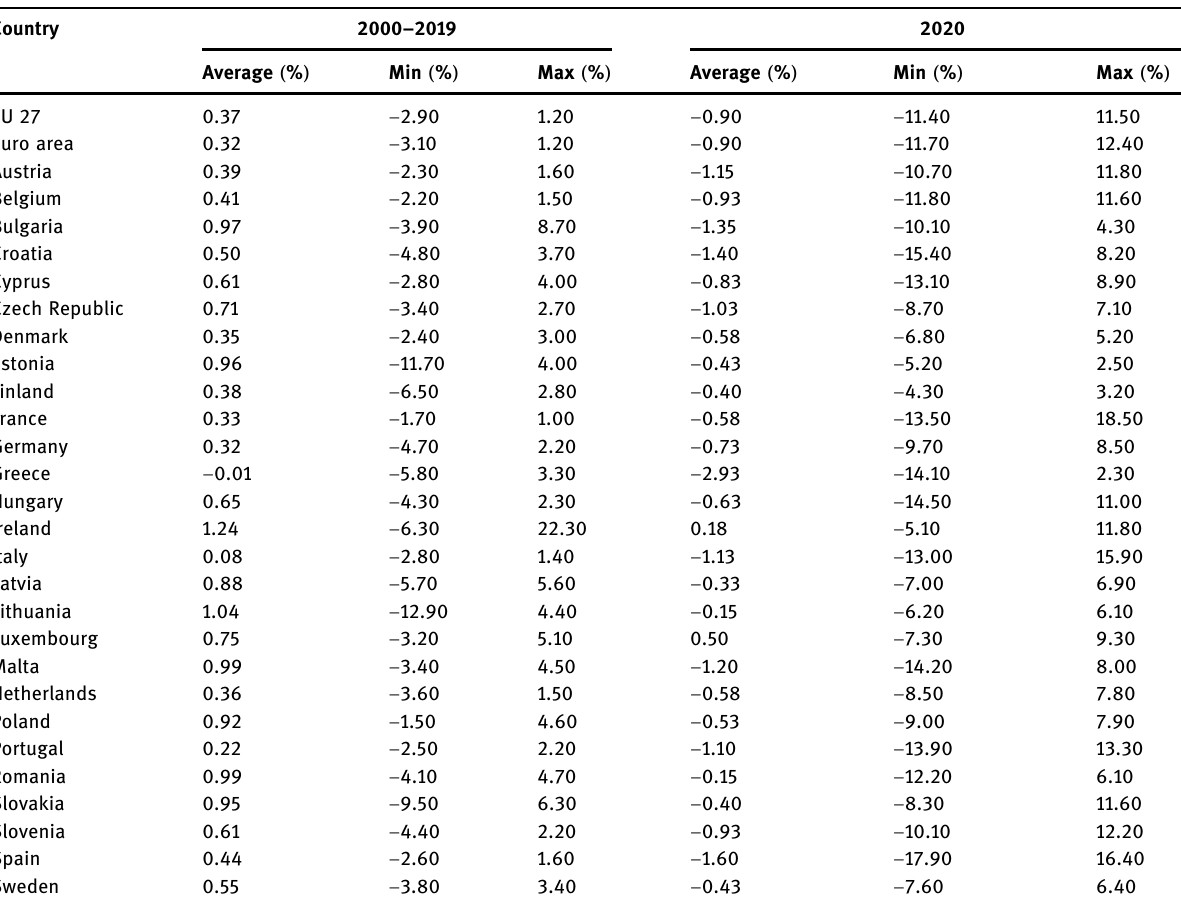
Table 6: Descriptive statistics for GDP growth Country